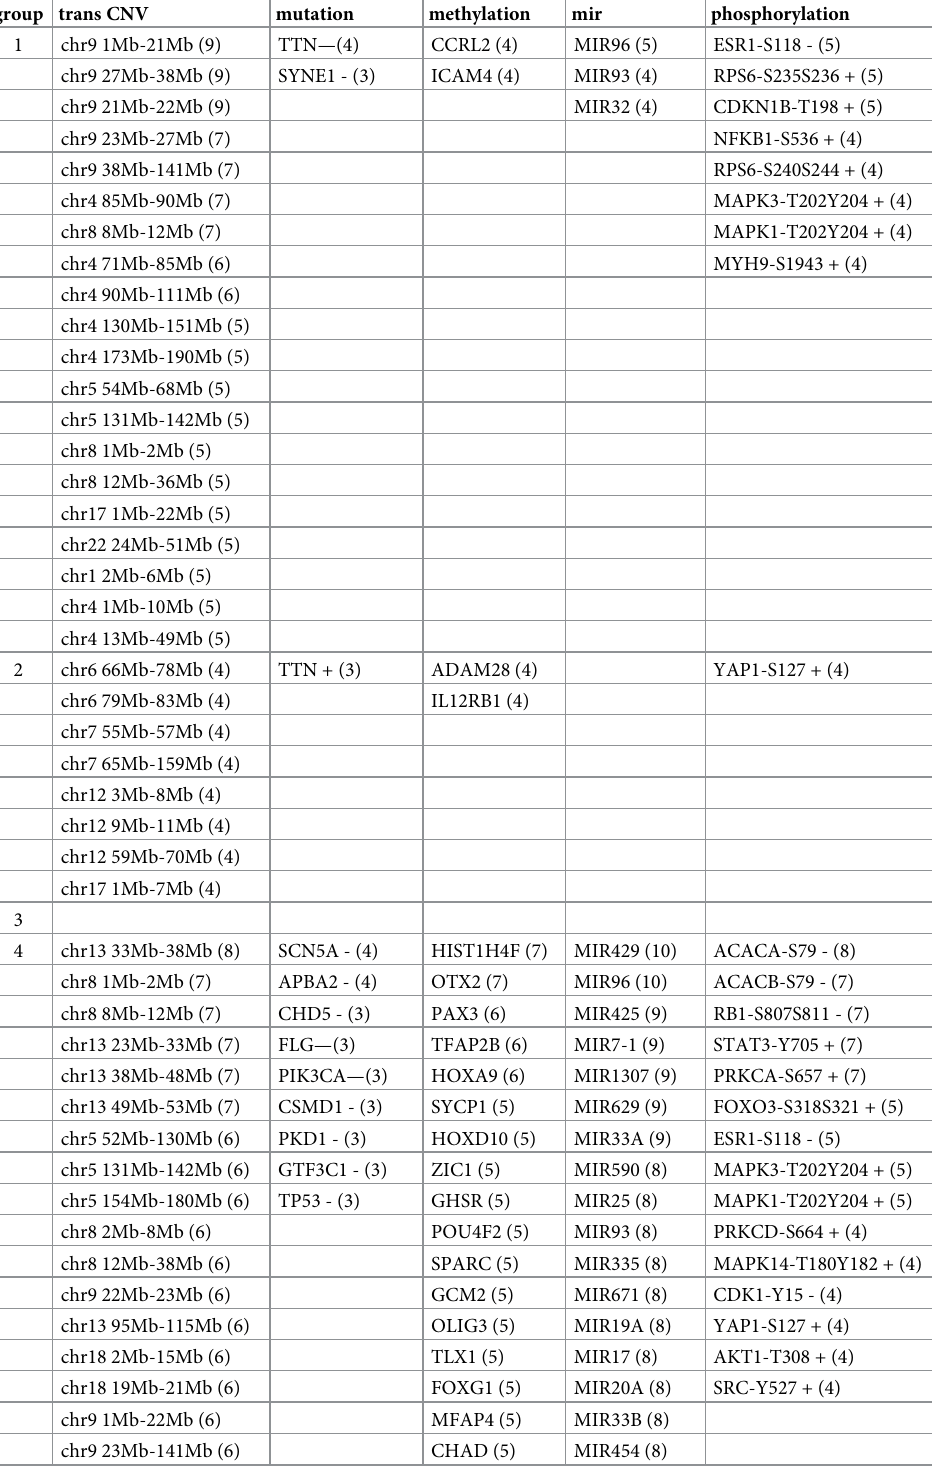
Table 4. The top-ranking Recurrent Effectors for the 17 Super Module Groups. Numbers within parentheses indi- cate the occurrences in Super Modules within a Super Module